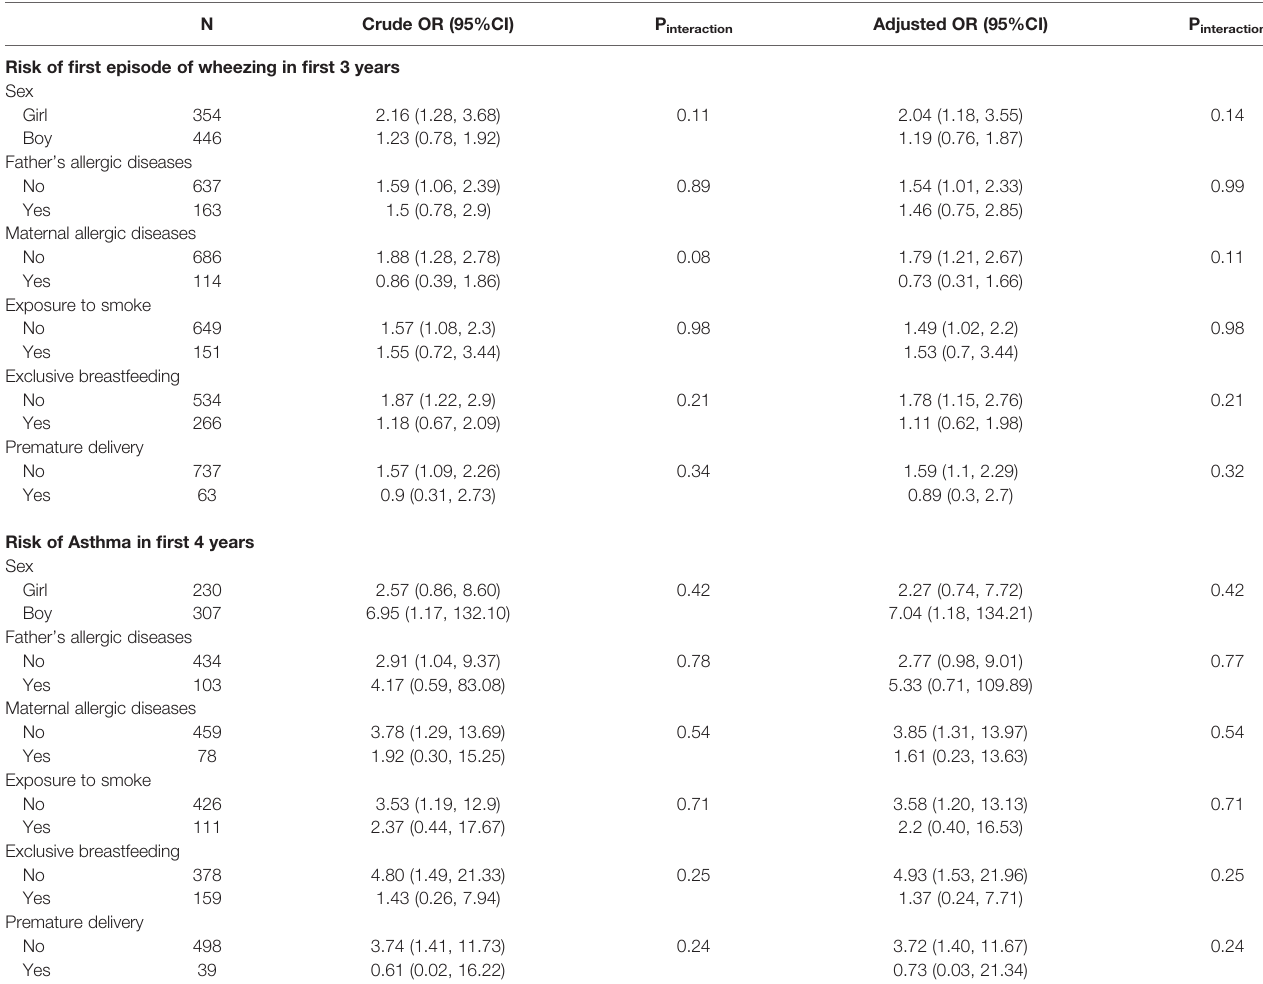
TABLE 2 | Subgroup analyses on the association between caesarean delivery and asthma or fi rst time of wheeze. N Crude OR